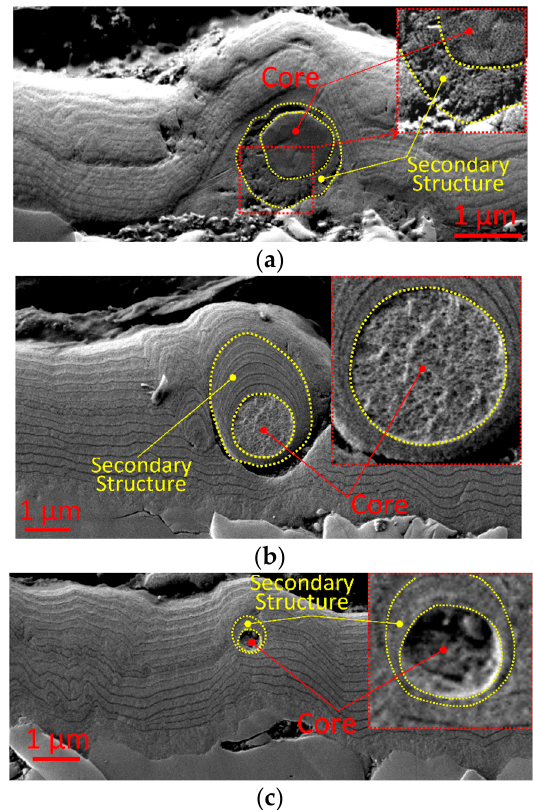
Figure 2. ( a ) the microdroplet of Cr–Mo, embedded into the structure of the Ti–TiN–(Ti,Cr,Mo,Al)N coating, ( b , c ) the microdroplets of Nb–Zr, embedded into the structure of the Ti–TiN–(Ti,Al,Nb,Zr)N coating (SEM 2).